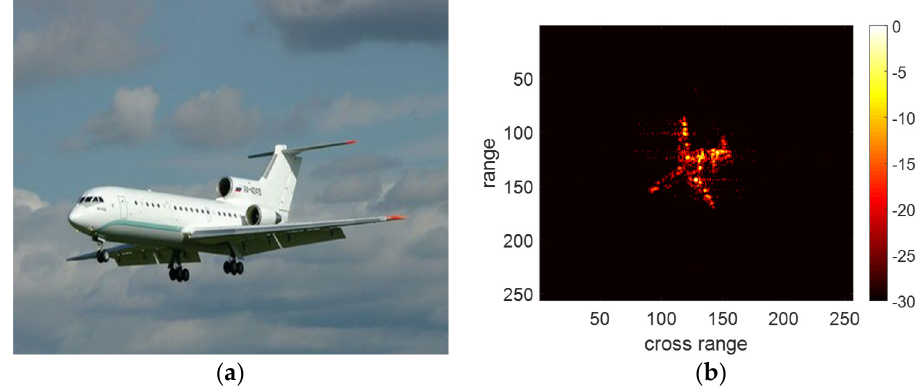
Figure 4. Yak-42 ( a ) The shape of the Yak-42. ( b ) The RD imaging result of the